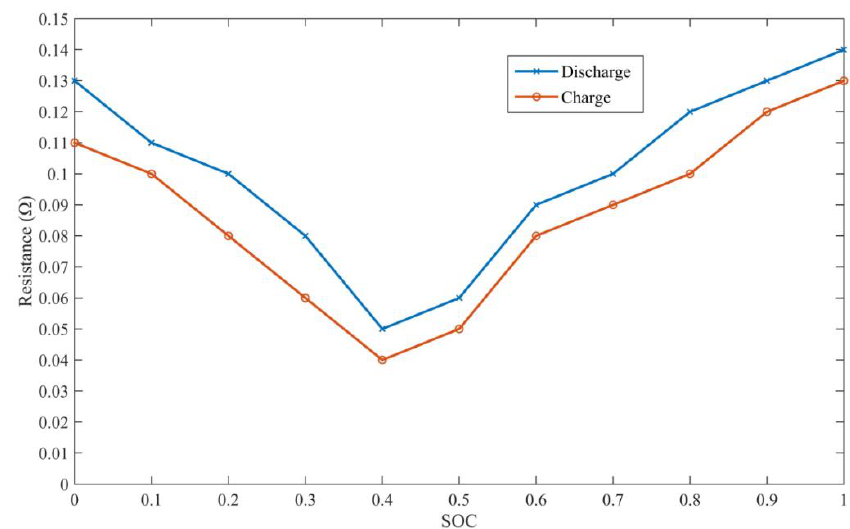
Figure 5. The resistance of No.1 battery.